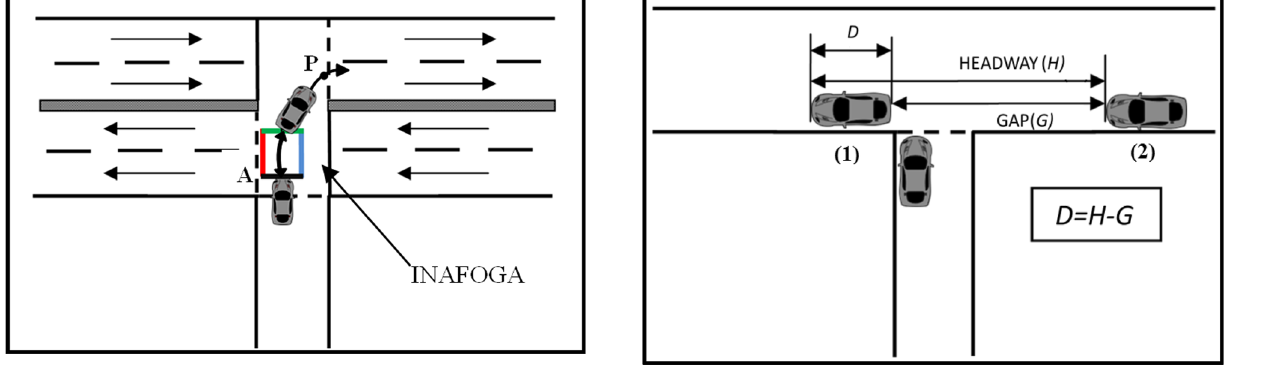
Fig. 6 Difference between gap